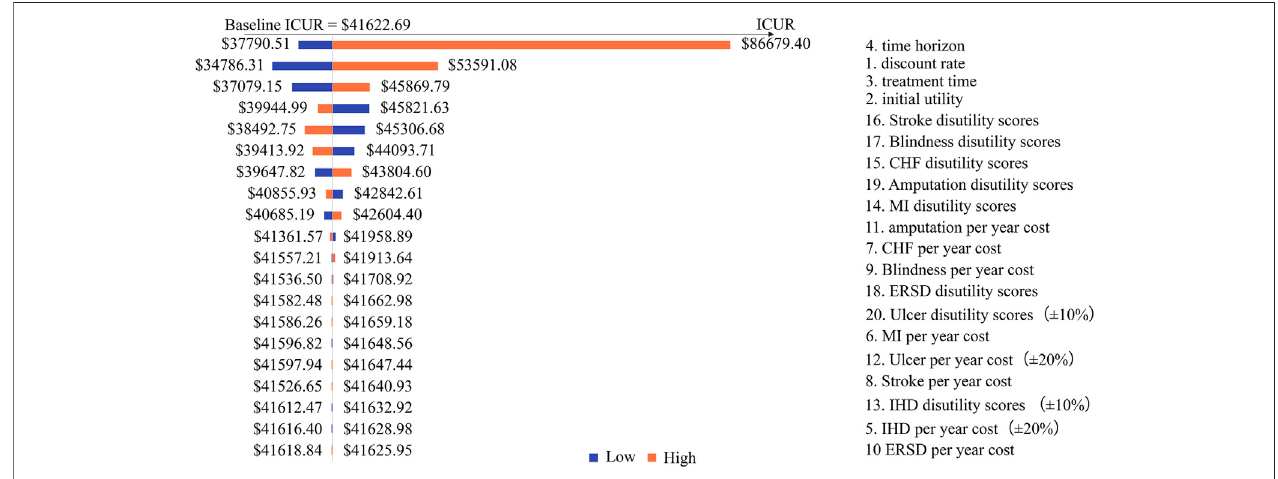
FIGURE 2 | Tornado diagram of the one-way sensitivity analysis (SEMA group vs. e-r EXEN group).